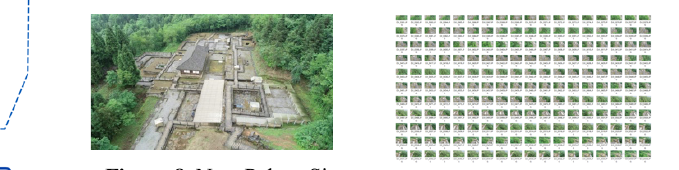
Figure 8. New Palace Site, Figure 9 . Photo collection for Hailongtun. part of the New Palace,